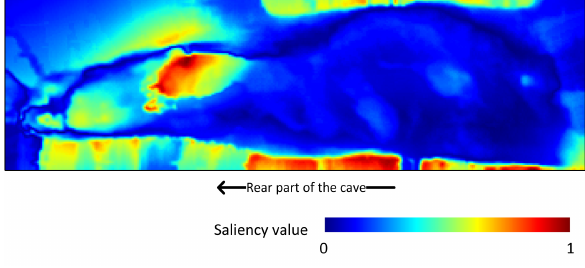
Figure 3. Saliency estimation on the raster, using Wang and Dudek (2014) method. The salient regions refer mostly to occluded areas that were interpolated in order to create the raster. once, without the need to divide it into sections.